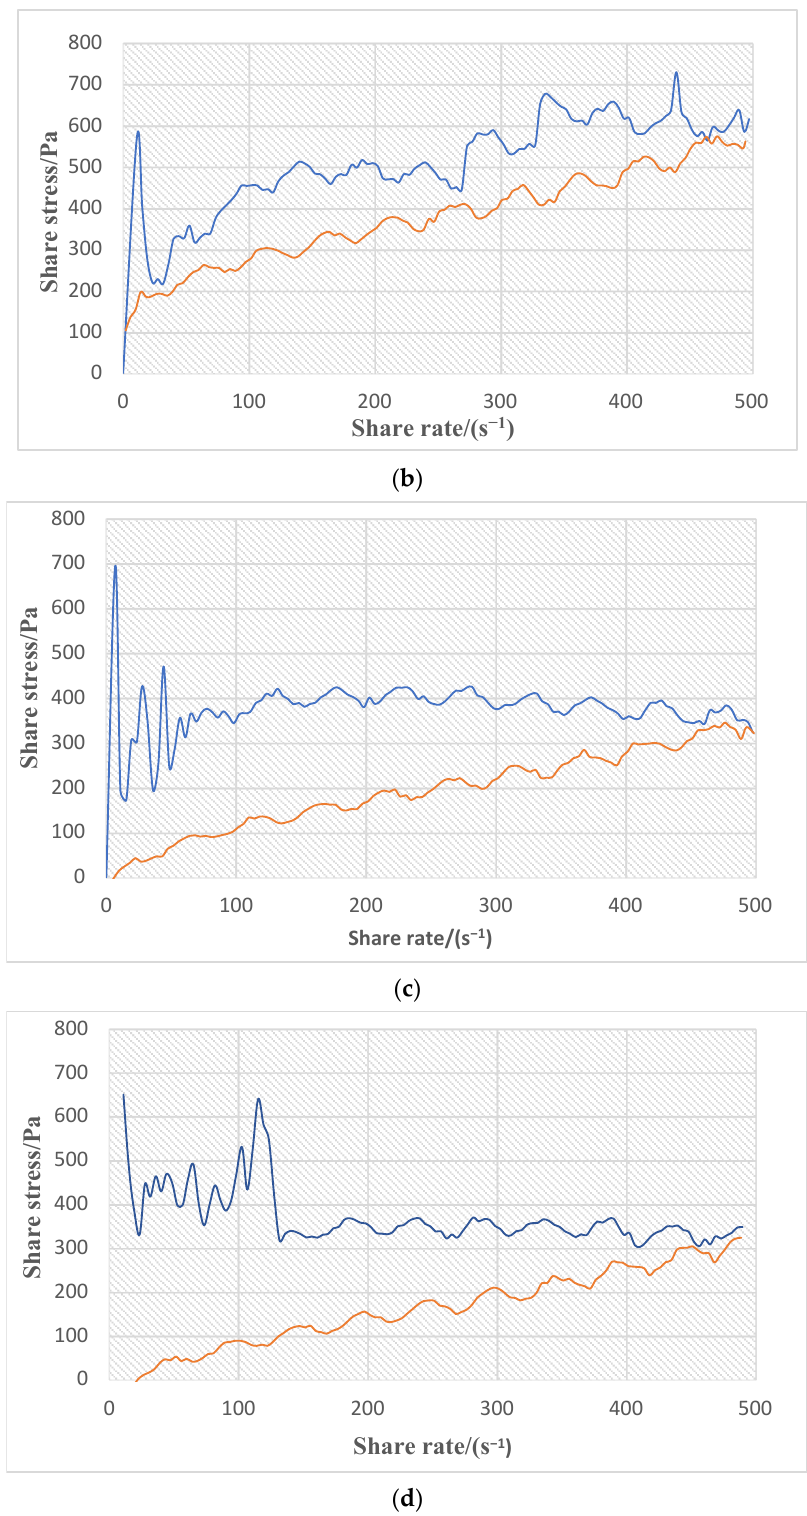
Figure 8. Thixotropic ring after grease freeze–thaw for 7 times: ( a ) PTFE; ( b ) Graphene; ( c ) CNTs; ( d ) WS 2 .